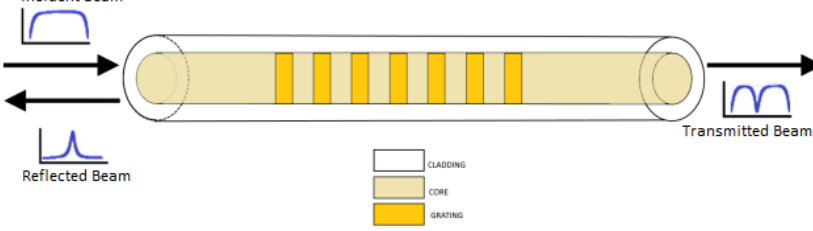
Figure 33. The schematic drawing of a simple FBG and the response spectra for the incident, reflected and transmitted beams. Reprinted under Creative Commons CC BY license